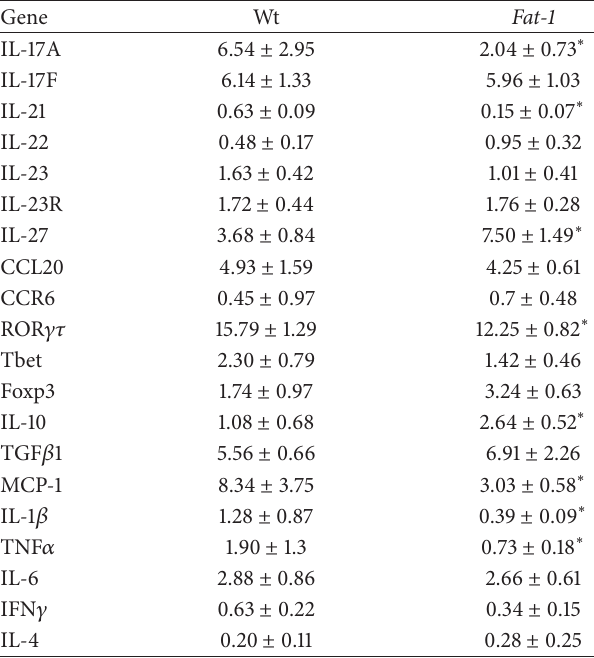
Table 4: Colonic mucosal mRNA expression in Wt, Het, and Null Fads1 TNBS-treated mice 1